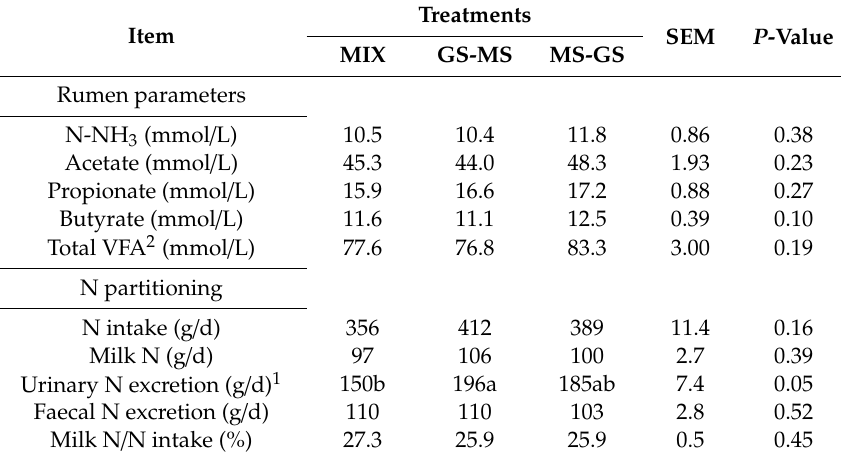
Table 4. Rumen parameters (VFA, N-NH 3 and rumen pH) and N partitioning (N intake, milk N, urine N and feces N) of grazing dairy cows supplemented with 50:50 grass and maize silage in the morning and afternoon (MIX), grass silage in the morning and maize silage in the afternoon (GS-MS) or maize silage in the morning and grass silage in the afternoon